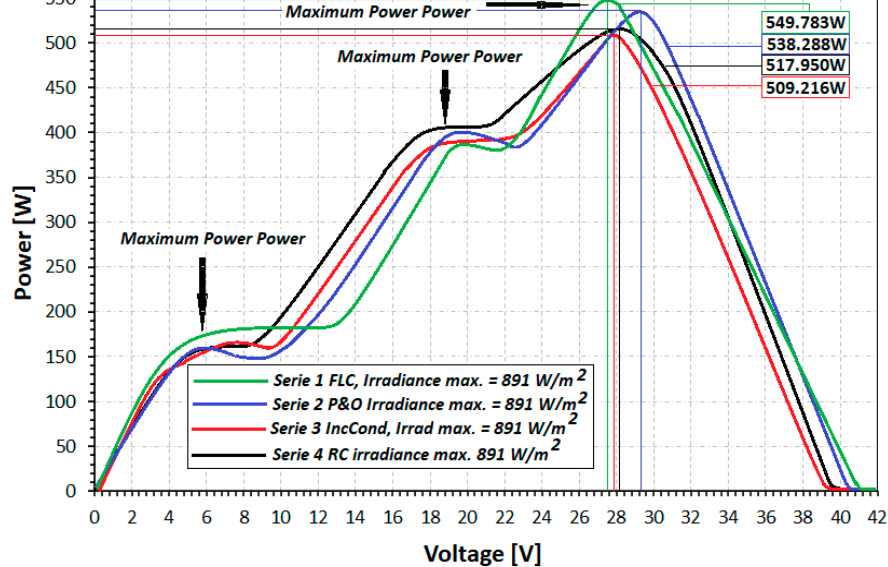
Figure 19. Comparison between MPPT techniques for 4 algorithms regarding the MPP determina- tion for P-V characteristics of an industrial PV